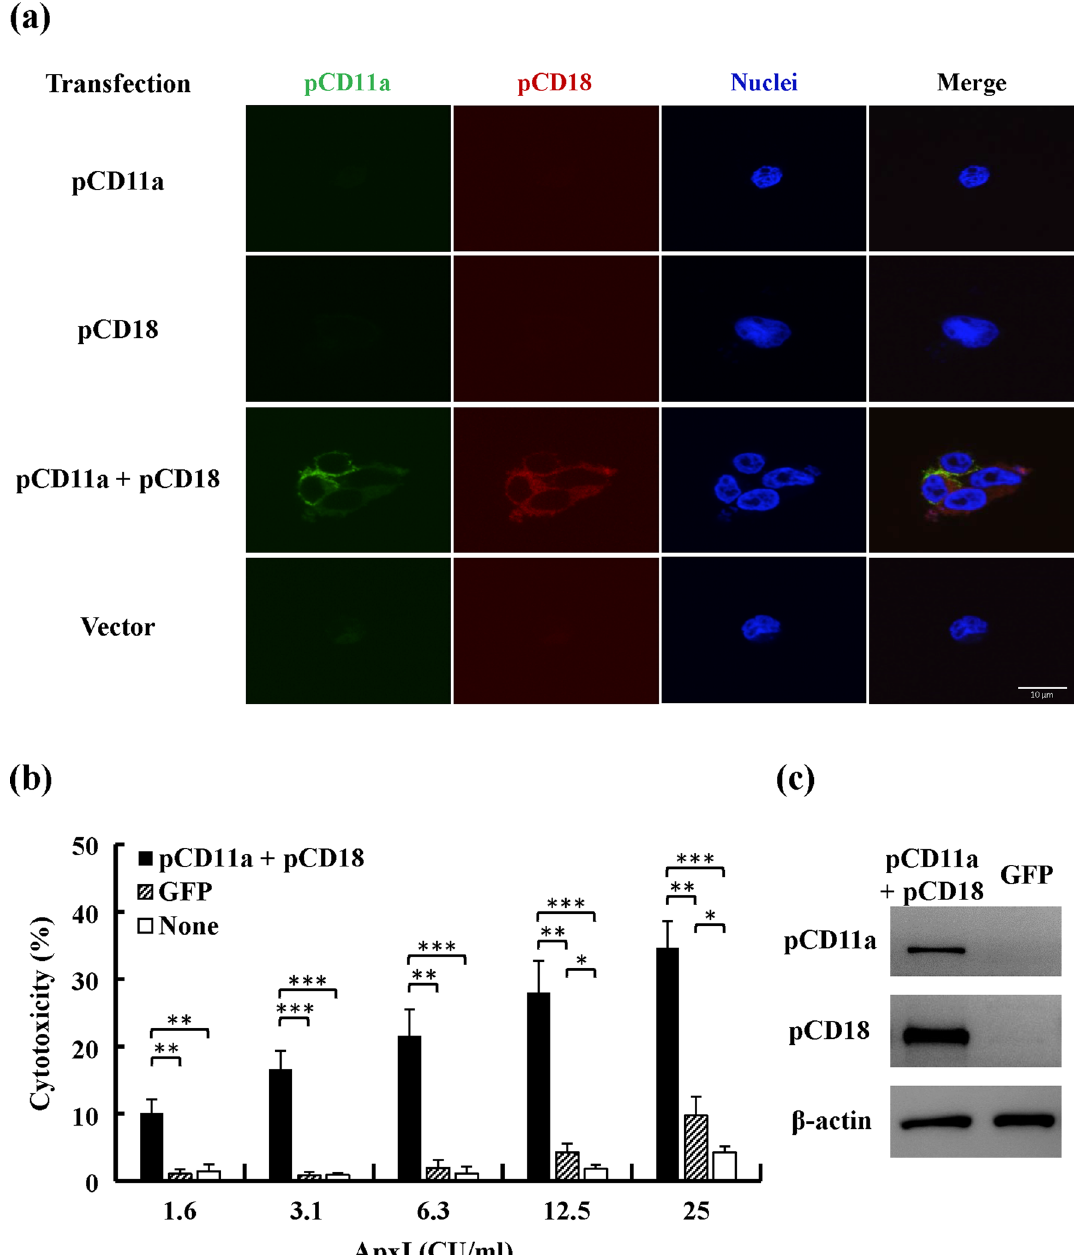
Figure 1. Porcine LFA-1 confers susceptibility to ApxI in HEK 293T cells. ( a ) HEK 293T cells were transfected with plasmids expressing porcine CD11a (pCD11a) and/or porcine CD18 (pCD18) or the corresponding empty vector. Ectopic expression of pCD11a and pCD18 was examined using confocal microscopy. Confocal images show the subcellular localization of pCD11a (pseudogreen), pCD18 (pseudored), and nuclei (pseudoblue). ( b ) Cells were transfected with plasmids expressing pCD11a and pCD18, green fluorescent protein (GFP), or non- transfected (None) for 24 h, followed by incubation with 1.6–25 CU/ml of ApxI for 5 h. The culture supernatants were collected and analyzed using the LDH release assay. Data are from three independent experiments of triplicate determinants. Error bars represent the standard deviations. * p < 0.05; ** p < 0.01; *** p < 0.001. ( c ) Cells were transfected with plasmids expressing pCD11a and pCD18 or GFP. Expression of pCD11a and pCD18 was examined using Western blot analysis. Immunoblots were also probed with an anti-β-actin antibody as the loading control. The grouping of blots was cropped from different portions of the same gel and exposed separately. Uncropped blot images for ( c ) are presented in Supplementary Figure